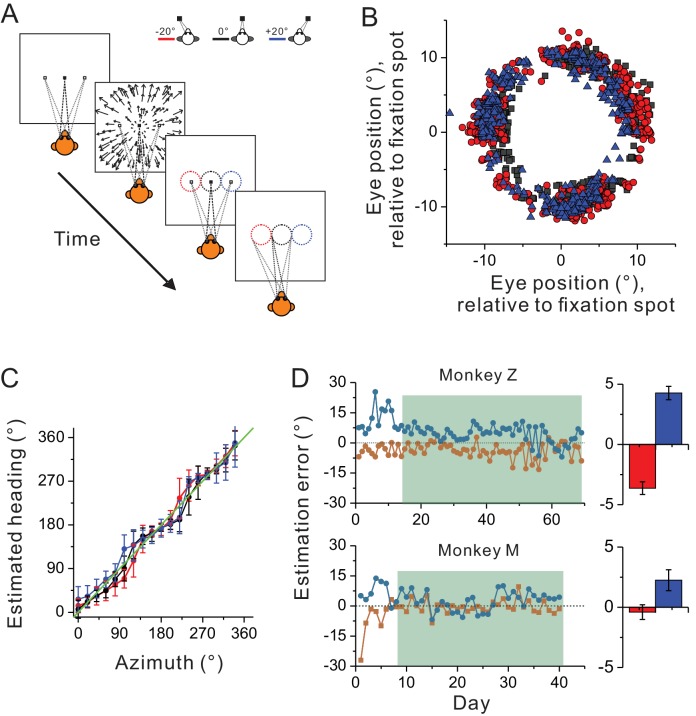
Heading estimation task in the visual condition.(A) Schematic illustration of the heading estimation task. The four panels depict the event sequence in one trial. Each trial begins with one of the three fixation locations (−20°, 0°, or 20°). After capturing fixation, visual optic flow is provided simulating heading in the horizontal plane. Headings are varied with a resolution of 20°, spanning a full 360° range. At the end of the trial, a target ring appears for ocular motor response. The ring is made of 36 dots apart by 10°. It is 20° in diameter, and its center is aligned with the fixation location in each trial (−20°, 0°, or 20°). Saccade endpoints within a window of 5 × 5° are taken as correct choice and the animals will be rewarded. Red, black and blue symbols represent eccentric fixation at −20°, 0° and 20°, respectively, and are the same for the rest of the figure. (B) Behavioral data from one experimental session with 30 repetitions for each stimulus condition. Note that saccade endpoints are plotted relative to the center of the target ring instead of the visual screen, thus data from the three fixation locations are roughly overlapped in this plot. (C) Mean and circular SD of the monkey’s heading estimates are plotted as a function of the real heading direction. The green diagonal line represents perfect performance. (D) Performance of the two monkeys in the training (unfilled areas) and recording sessions (shaded areas). Heading estimation errors are evaluated by computing the difference in the heading estimate between the eccentric and central fixation conditions. Right histograms represent the mean ± s.e.m. of the data in the recording sessions (shaded area).